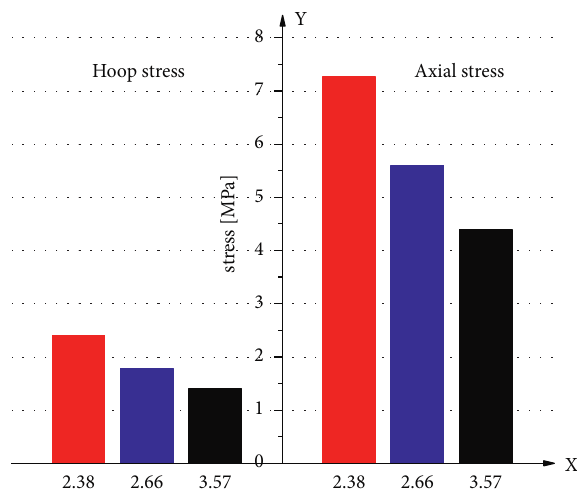
Figure 18: Self-stress of microexpansive concrete for different length-to-diameter